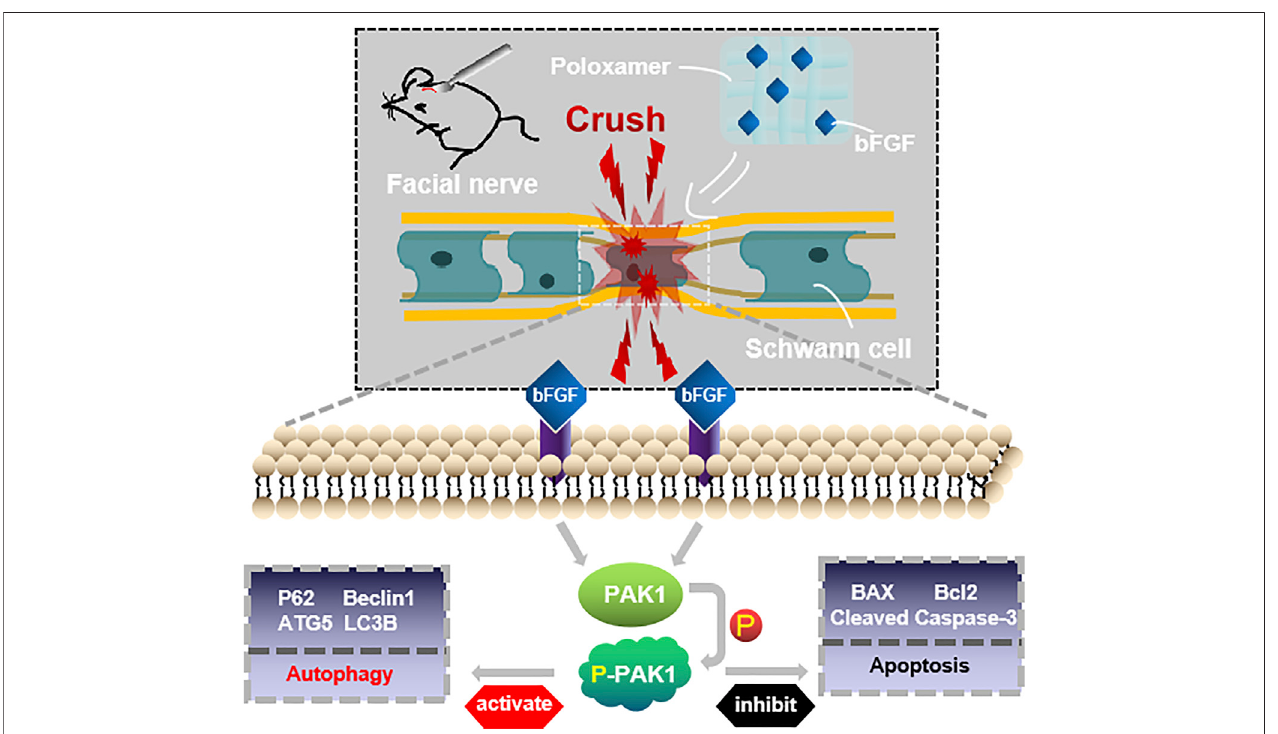
FIGURE 7 | Conceptualization. The treatment of injured facial nerve with thermosensitive poloxamer loaded with bFGF. The bFGF was released steadily and continuouslyat theoriginalsite ofinjury,and bFGFtreated theinjured facial nerve byactivating the PAK1signaling pathway topromote autophagyand inhibit apoptosis.